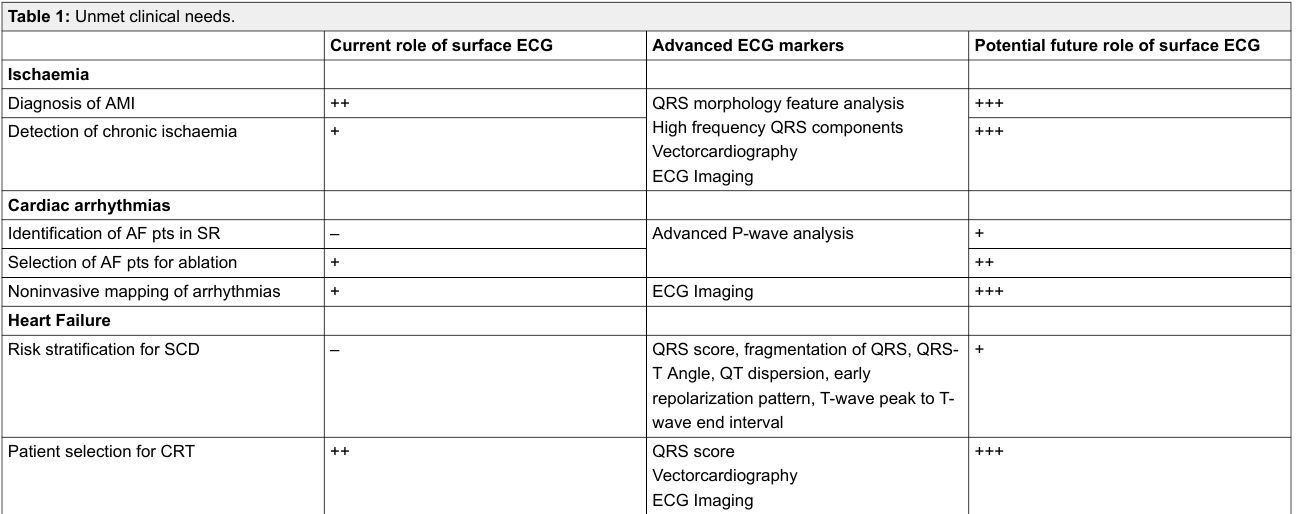
Current role of surface